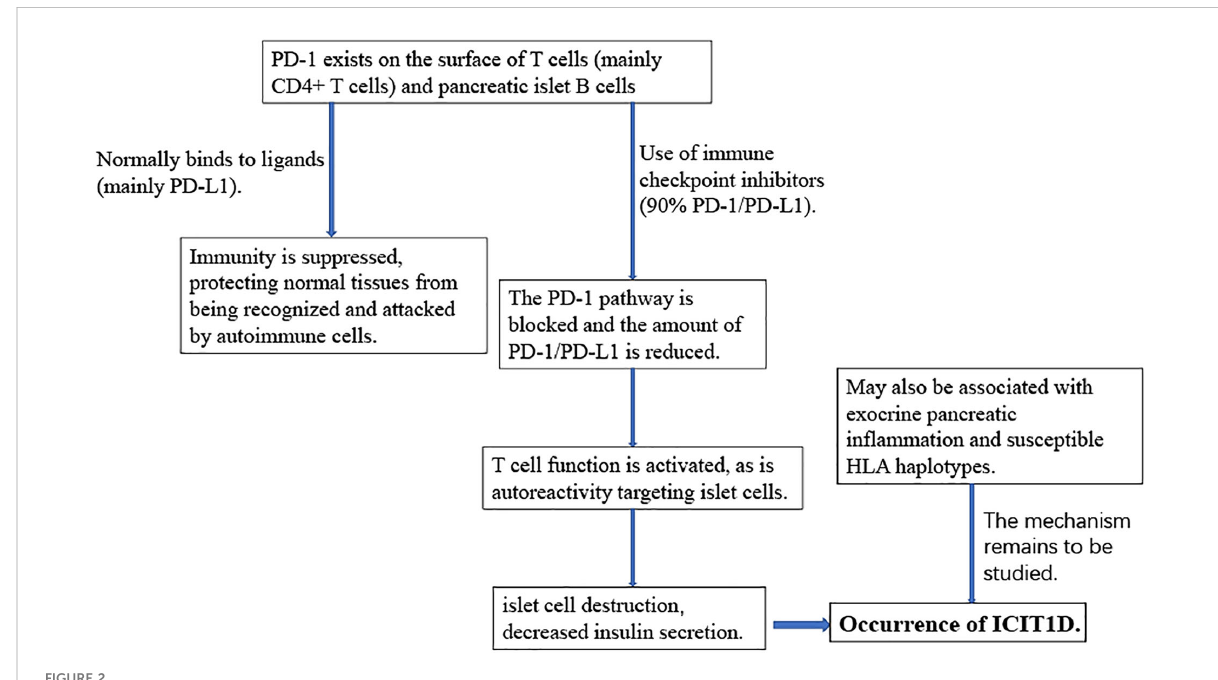
FIGURE 2 The roles of the PD-1/PD-L1 pathway in ICI-induced